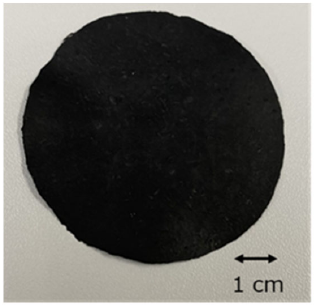
Figure 2. Operation of actuator. ( a ) Before applying voltage. ( b ) After applying voltage.